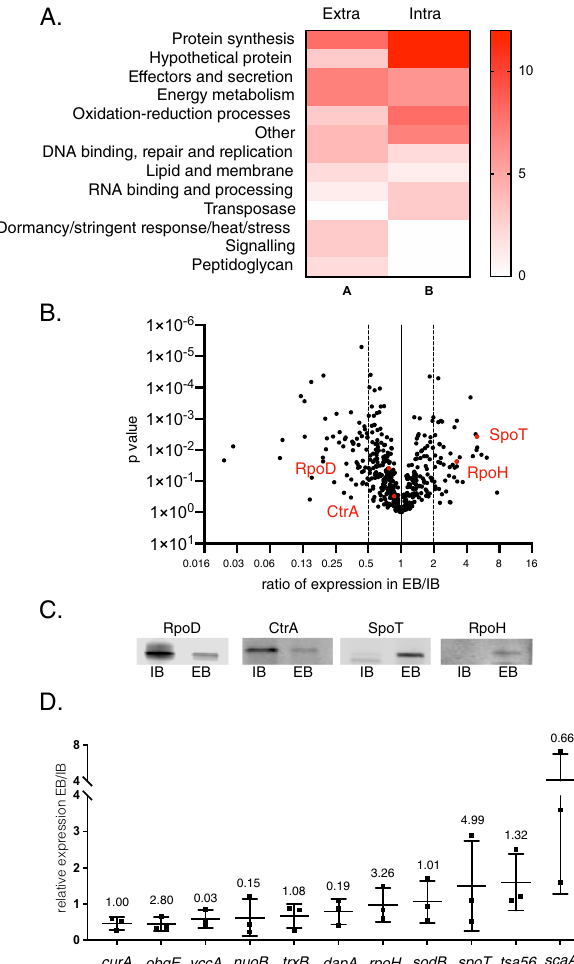
Fig. 3 Intracellular and extracellular forms of Ot have different levels of certain proteins. A Pathway analysis of proteins present at >2X difference between IB and EB forms of Ot (60 proteins in IB, 47 proteins in EB). Bacteria were grown in triplicate in L929 cells at an MOI of 410:1 and harvested 4 days post-infection. IB and EB Ot were isolated and analysed by shotgun proteomics. B SpoT and RpoH are present at higher levels in EB compared with IB Ot as measured by proteomics described in A . Statistical signi fi cance was determined using a t test with GraphPad Prism software. C Immunoblot analysis showing relative levels of four Ot proteins SpoT, RpoD, RpoH, and CtrA in IB and EB Ot. Loading was normalized by measuring bacterial genome copy number using qPCR and loading the same number of IB and EB Ot in each pairwise comparison. Samples taken from the same experiment are used for the four antibodies in this fi gure, with the same amount loaded in each immunoblot. Uncropped immunoblot images with molecular weight markers are given in Supplementary Fig. 4. This data con fi rms the trends observed in the proteomics analysis for these four proteins. D RT- qPCR analysis showing relative levels of 11 genes expressed in EB and IB Ot. Bacteria were isolated from L929 cells 4 days post-infection at an MOI of 672:1, 300:1, and 560:1. n = 3 independent experiments. Data are presented as mean values ± SD. Gene expression levels were normalized using three genes: mipZ , ank12 , and 16S . Mean and standard deviation values are shown. The ratio of protein levels in EB/IB, as found in the proteomics experiment in 2A, is given above each gene for